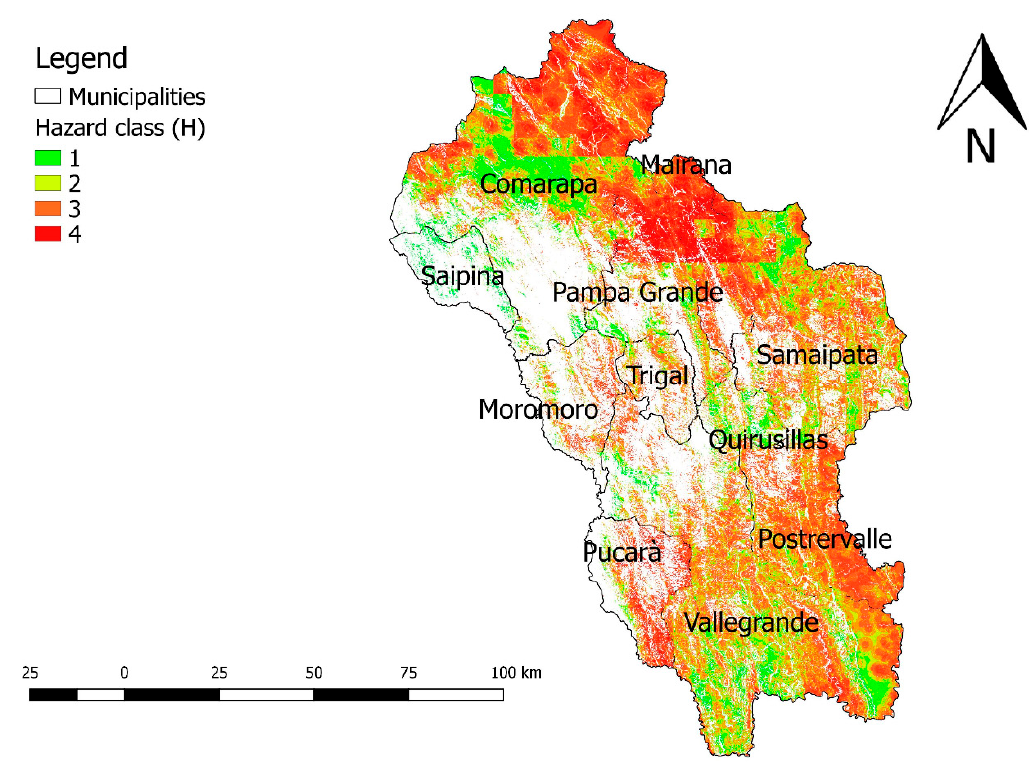
Figure 7. Integrated hazard (H) map of the “Valles cruceños” region, H varies from 1 (lower) to 4 (higher). Bolivia, 2019.